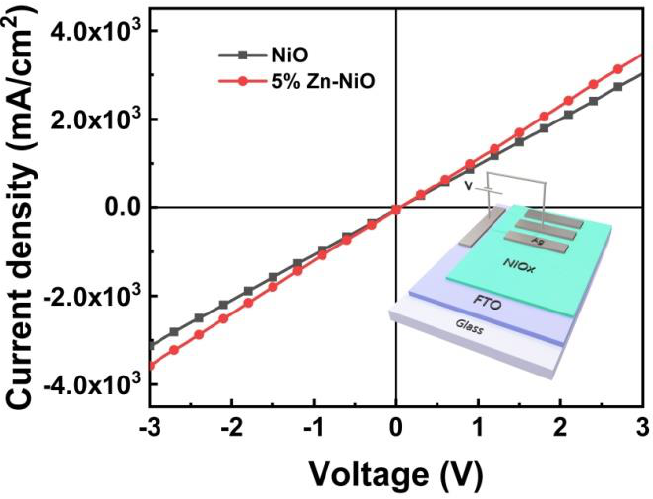
Figure 9. I – V characteristics of hole-only devices made with NiO x and 5% Zn-NiO x thin films. Charge extraction and non-radiative recombination at the perovskite and HTL inter- face was evaluated using steady-state photoluminescence (PL) and time-resolved photolu- minescence (TRPL). Figure 10a,b show the PL spectrum and TRPL profile for perovskite films over NiO x and 5% Zn-NiO x thin films. The offset in the valence band edge plays a major role in charge recombination. Mismatches in the valence band edge between HTL and perovskite layer leads to more recombination at the interface and results in lowering of the Voc [45]. PL exhibited by the perovskite layer was significantly reduced by the HTLs. Noteworthy levels of PL quenching were shown with both types of film, demonstrating high levels of efficiency of charge extraction for Zn doped NiO x thin films. These findings accord with previous research [43]. The TRPL profile was measured employing time- correlated single-photon counting. Calculation of the PL lifetime decay was undertaken using tail fit with a biexponential decay function, as shown in Equation (1),